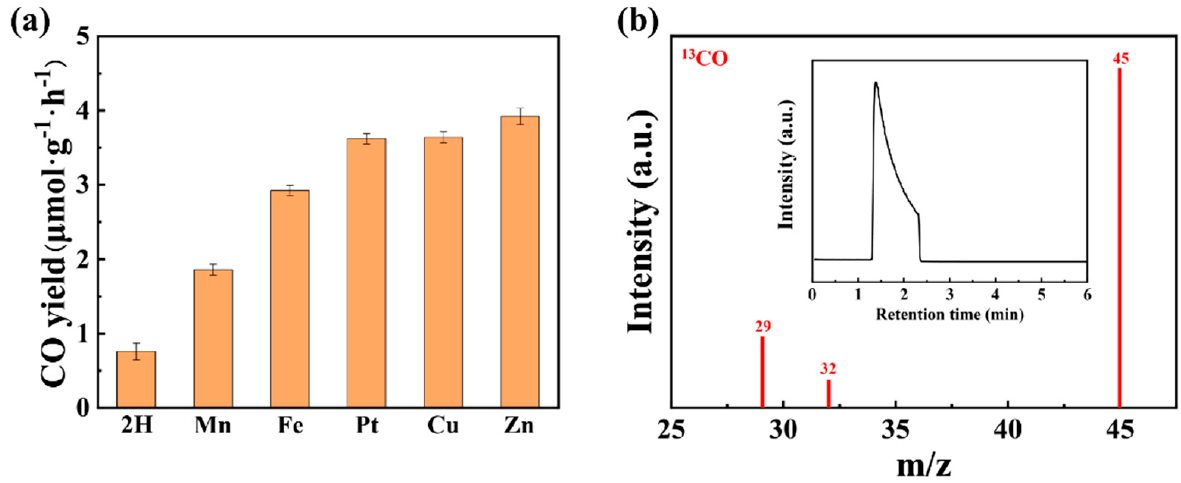
Figure 5. ( a ) The average CO yield of PCN − 222(2H), PCN − 222(2H&Pt), PCN − 222(2H&Fe), PCN − 222(2H&Cu), PCN − 222(2H&Zn), and PCN − 222(2H&Mn). ( b ) Mass spectra of 13 CO (m/z = 29) produced over PCN-222(2H&Zn) in the photoreduction of 13 CO 2 . In order to investigate the stability of PCN-222(2H&M), the PXRD profile (Figure 6a) was employed to verify the structures of all PCN-222(2H&M) materials, which could be well-preserved after CO 2 RR. Figure 6b shows that due to the structural stability of PCN-222(2H&Zn), the photocatalytic reactions could be recycled 3 times (5 h per time). Furthermore, three blank tests (without catalysts, without light irradiation, and without CO 2 in N 2 atmosphere) were performed, none of which generated the target product (Figure 6c), confirming the origin of CO during the CO 2 RR process. The photocatalytic CO 2 RR performance of PCN-222(2H&M) materials was significantly improved via the introduction of Zn ions into the porphyrin’s